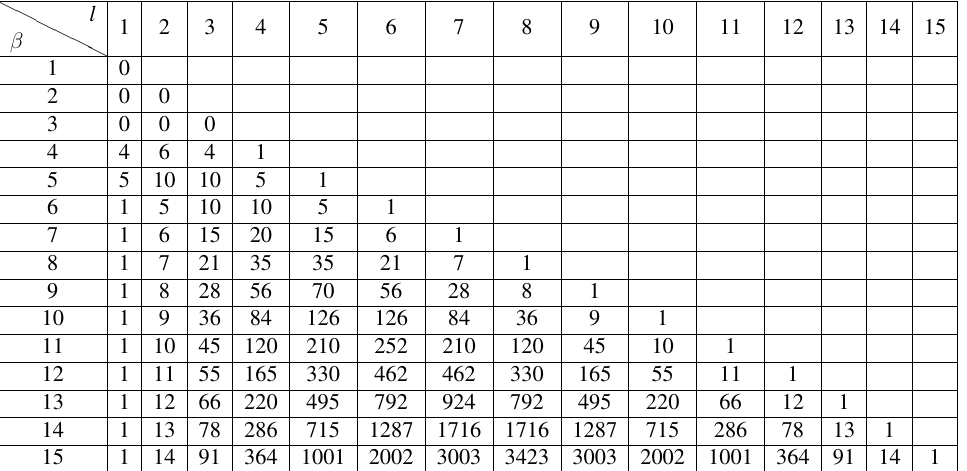
, l ) | is the number of superior eccentric dominating sets of Table: | sed ( W β W with cardinality l where 1 ≤ l ≤ 15 β